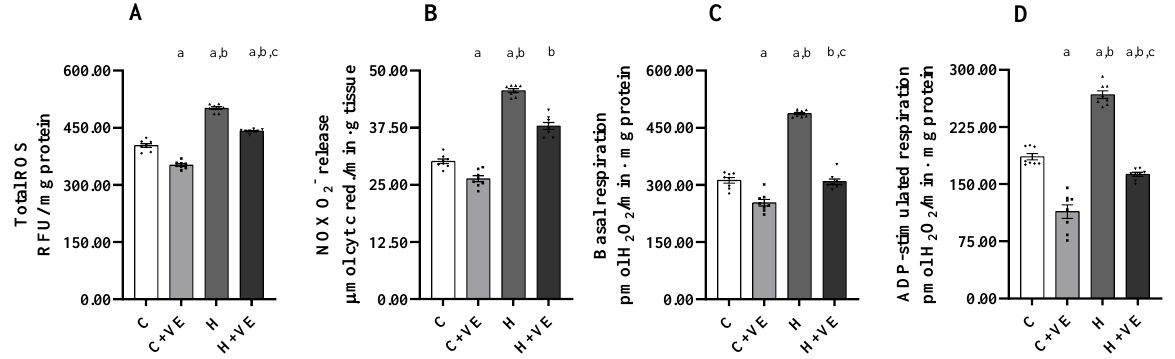
Figure 3. Total ROS content ( A ), NADPH oxidase (NOX) O 2 − release ( B ), mitochondrial H 2 O 2 release during basal ( C ) and ADP-stimulated respiration ( D ). C control rats; C + VE, vitamin-E-fed rats; H hyperthyroid rats; H + VE hyperthyroid and vitamin-E-fed rats. Values are the means ± SEM of eight different rats. p < 0.05 was chosen as the significance level. Meaning of the letters: a, p < 0.05 vs. C; b, p < 0.05 vs. C + VE; c, p < 0.05 vs. H (one-way ANOVA followed by Tukey post-test).